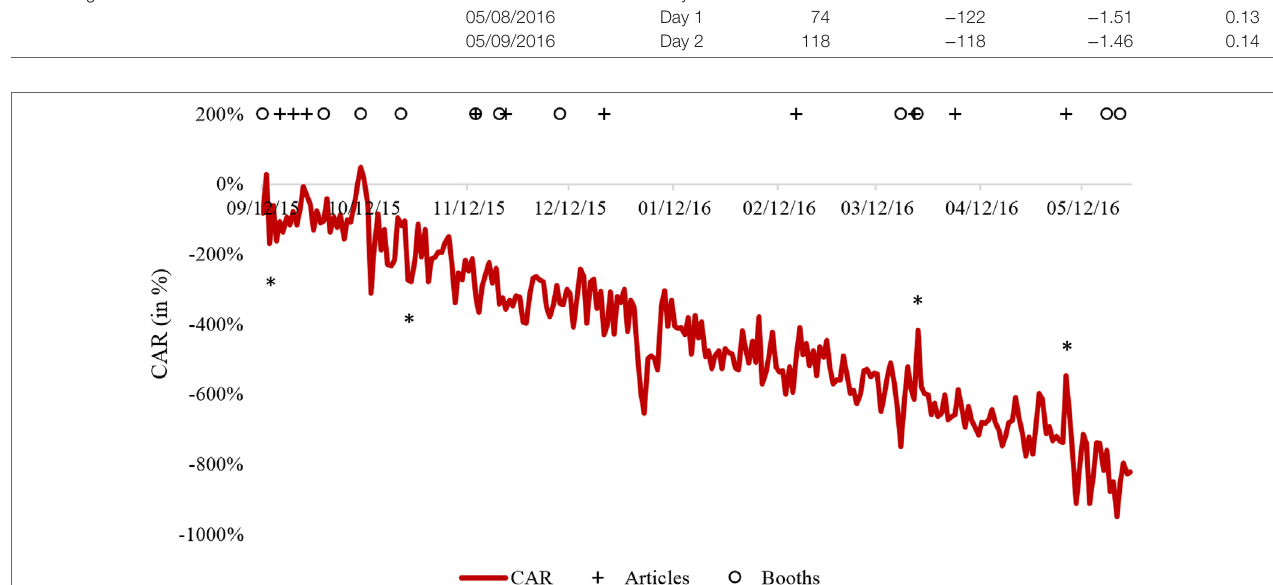
FigUre 3 | cumulative abnormal returns ( CAR ) for the testing period . The articles and the booths to promote Sport-Santé are identified by crosses and circles, respectively. *Statistically significant initiatives revealed by the event study ( p <